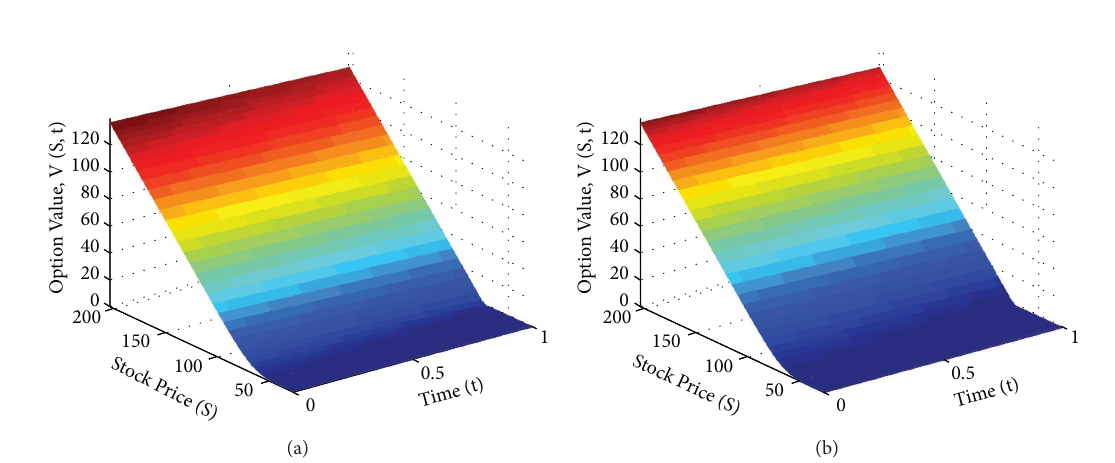
Figure 8: Linear Black-Scholes model by the Chebyshev spectral method (a) and by the differential quadrature method (b).